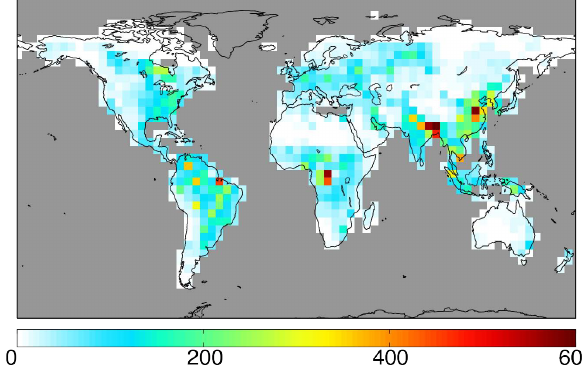
Fig. 7. Methane emissions [Mg per grid square per month] in the GEOS-Chem CTM for July–August 2008 at 4 ◦ × 5 ◦ horizontal res- olution. These are taken as the “true” emissions for the OSSE inver- sion of methane sources. Gray represents regions covered by ocean or